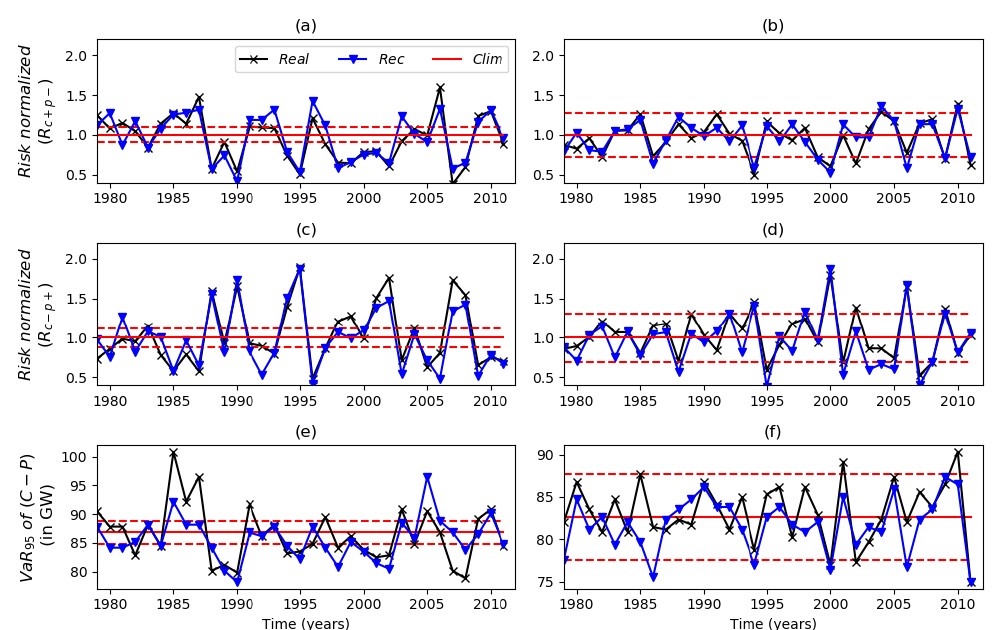
Figure 6. Time series of the real (black curves) and reconstructed (blue curves) measures risk compared with the climatological level of risk (in red). ( a ) Risk R c + p − in winter; ( b ) Risk R c + p − in fall; ( c ) Risk R c − p + in winter; ( d ) Risk R c − p + in fall; ( e ) Risk VaR 95 in winter; ( f ) Risk VaR 95 in winter. For risks R c + p − (panels a , b ) and R c − p + (panels c , d ) the risk measure is normalized by the climatological risk so that a value above (below) one highlight a higher (smaller) risk than normal., while for the risks VaR 95 , the risk is measured in GW. Dashed dotted red lines correspond significance levels at 10% as defined in the Appendix